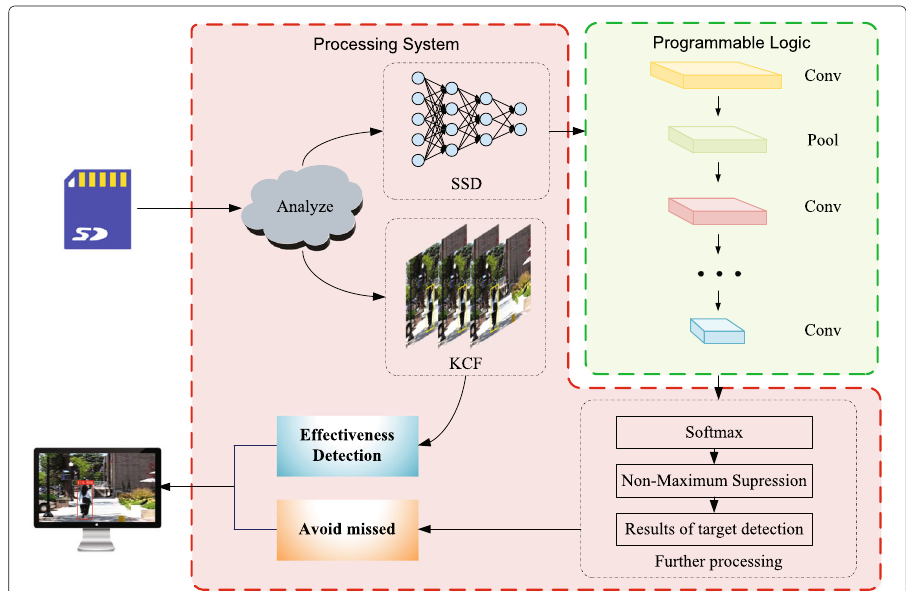
Fig. 8 Software and hardware partition of the system